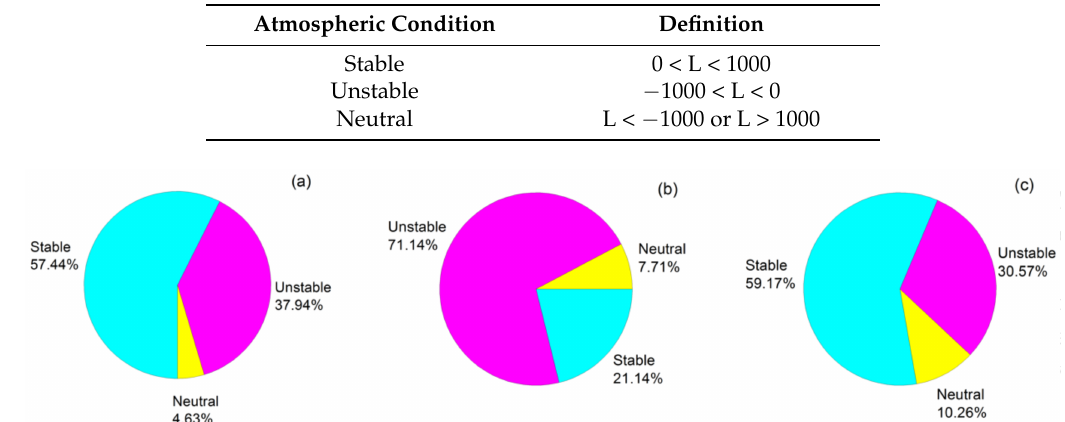
Figure 7. Frequency pie chart of different stabilities at the ( a ) Arou site; ( b ) Guantan site and ( c ) Daman